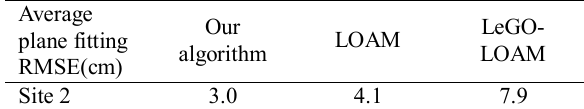
Table 3. Average plane fitting RMSE for Site